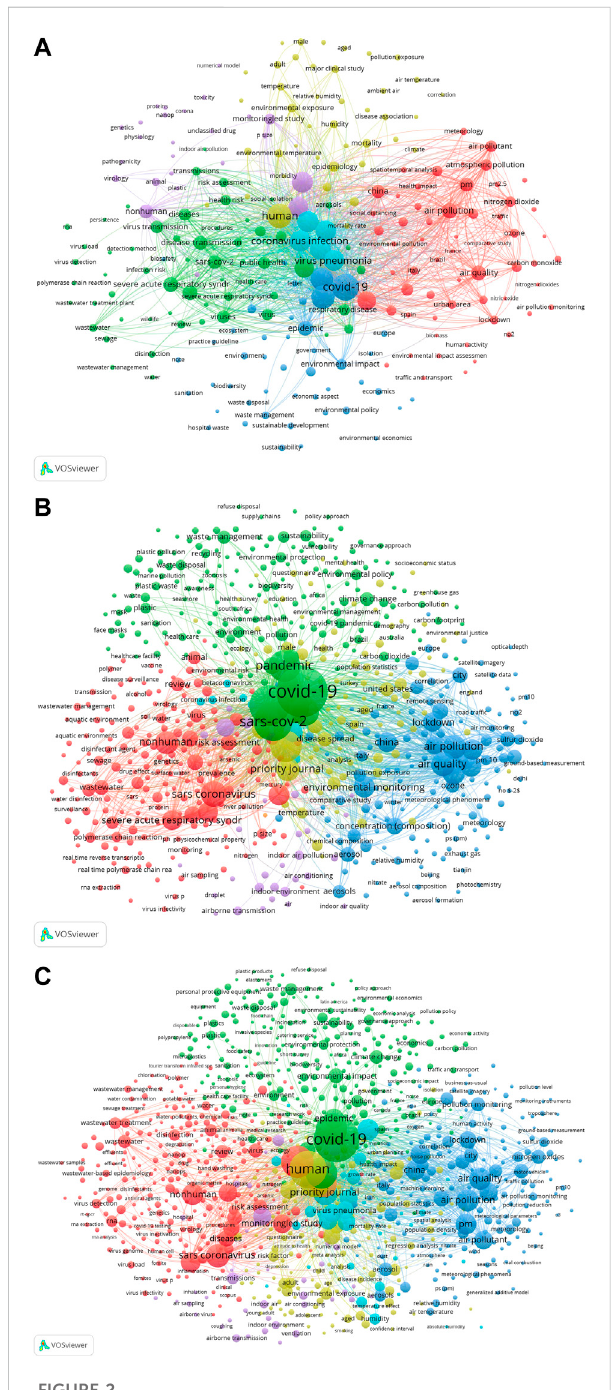
FIGURE 2 Term co-occurrence network map for all four clusters in 2020 (A , top ) , 2021 (B , middle ) , and 2022 (C , bottom ) . The size of the circles represents the occurrences of the keywords. The thickness and distances of lines represent the strength and association of the keywords. VOSviewer signi fi es each category or cluster of keywords with a unique